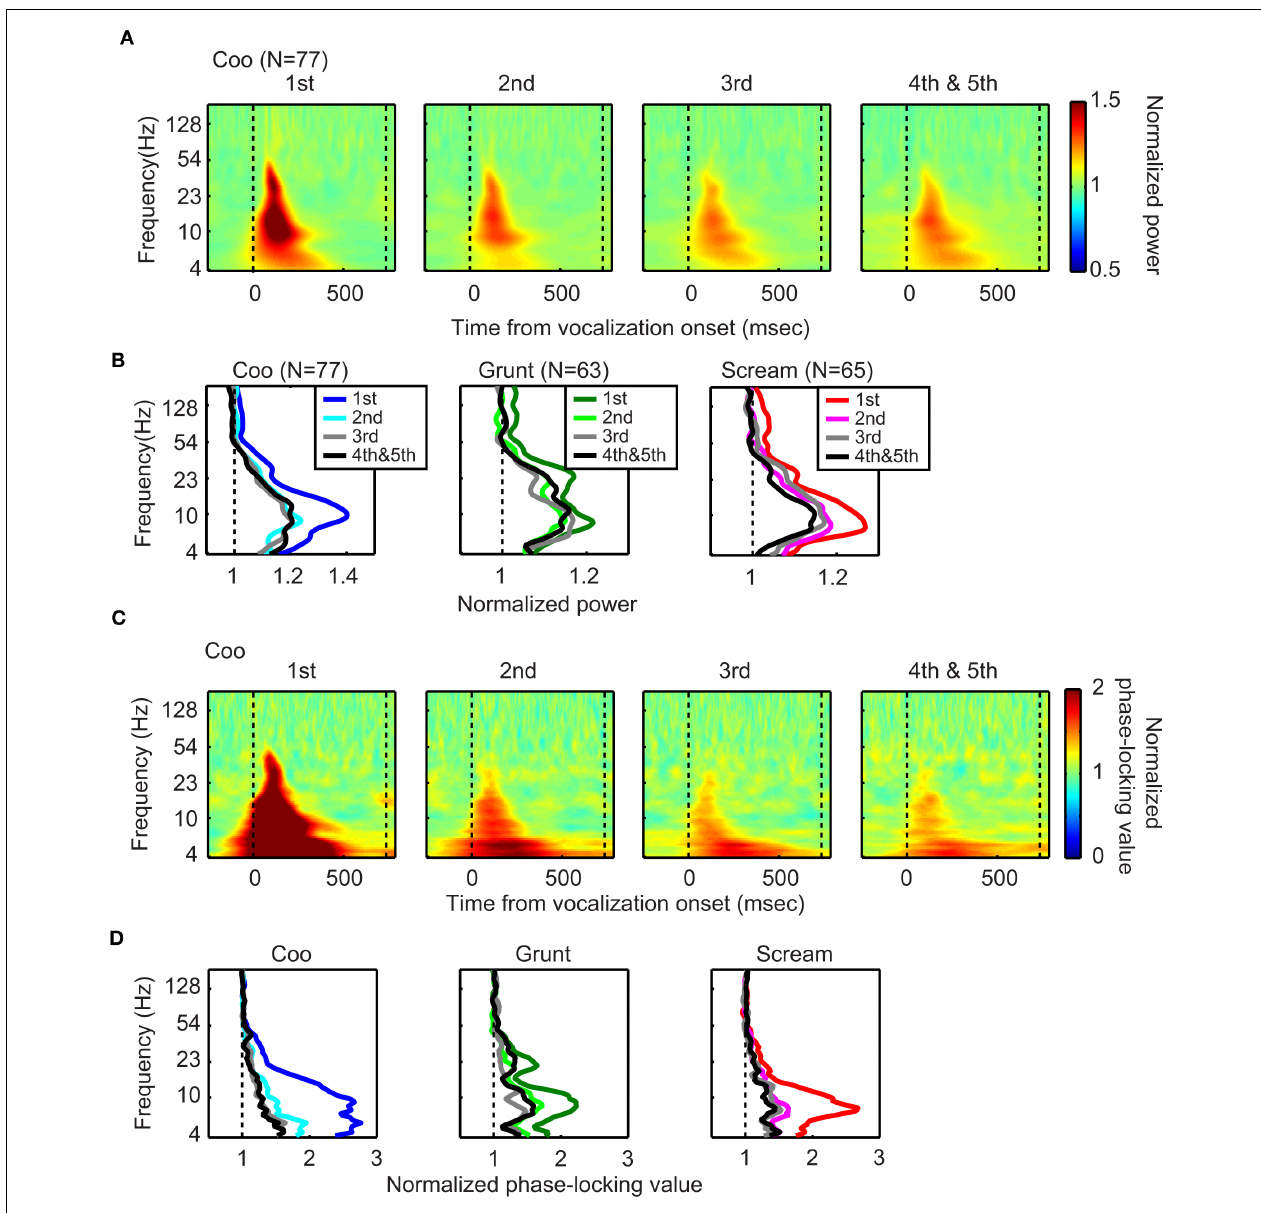
t = 0).The second dotted line indicates vocalization offset.The data in (B) illustrate the effect that repeated presentations of a vocalization had on the population spectra.The data in each column were generated from a different vocalization: coo (left; n = 77 sites), grunt (middle; n = 63 sites), and scream (right; n = 65 sites).Within each plot, the spectra are plotted as a function of stimulus presentation.The data in (C,D) illustrate the effect that repeated presentations of a vocalization had on phase-locking; the data in these two panels are organized analogously to that described in (A,B) , respectively.